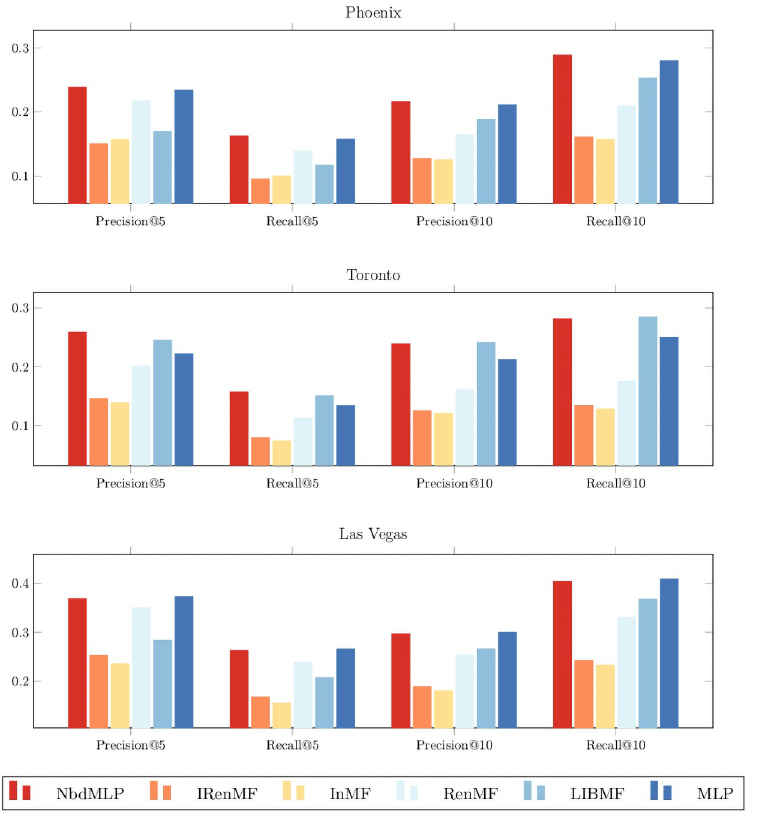
Fig 3. The precision and recall of NbdMLP and five